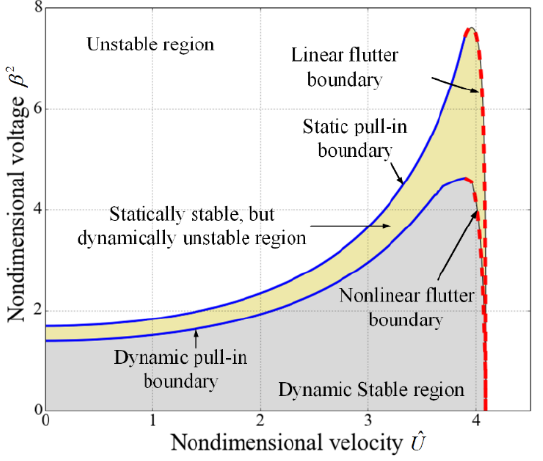
2 ˆ, U  ) plane for suspended